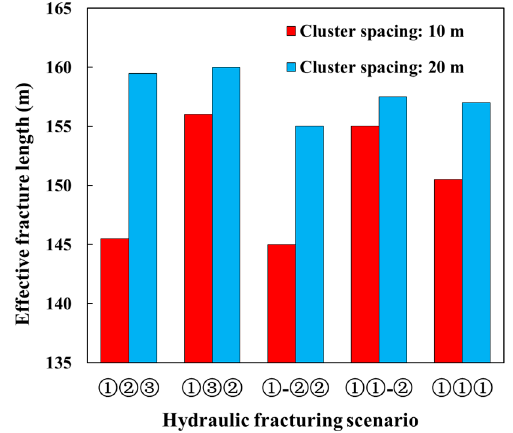
Figure 15. Variation of effective fracture length with different closely-spacing fracturing